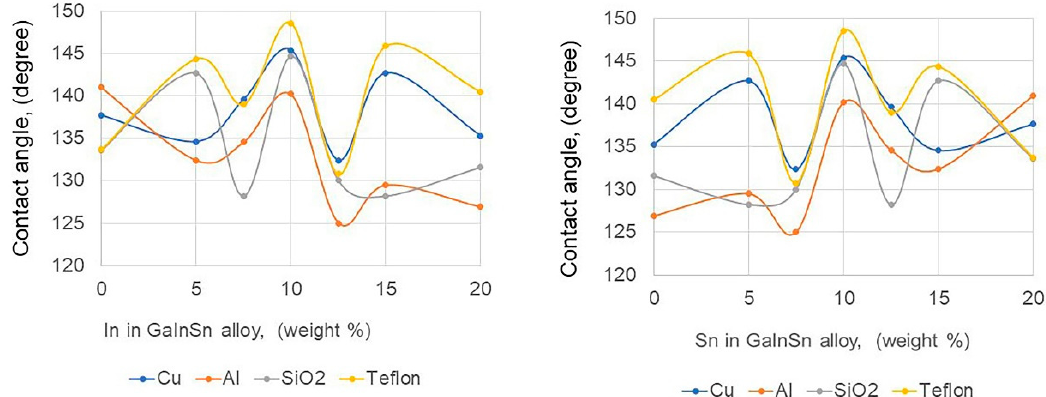
Figure 7. E ff ect of In and Sn content on the contact angle of di ff erent gallium alloys (80 wt.% of Ga Figure 7. Effect of In and Sn content on the contact angle of different gallium alloys (80 wt.% of Ga in in Ga 80 InSn at 20 °C). Ga 80 InSn at 20 ◦ C).